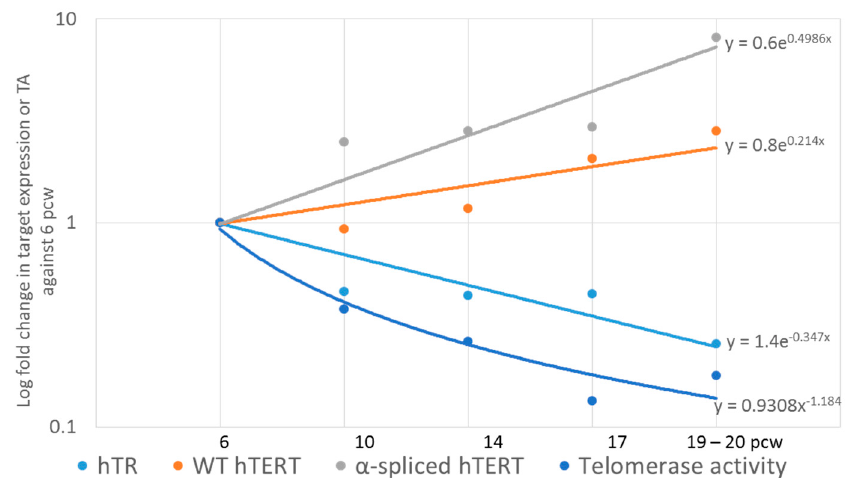
Figure 3. Summary of changes in expression of telomerase-related genes in fetal brain, young and old cortices. Data correspond to those from Figure 1. Telomerase activity and 2 −ΔΔ Ct of all data were acquired by normalizing to 6 pcw instead of SH-SY5Y (in the case of 2 −ΔΔ Ct data), allowing fold change comparison of any time point with 6 pcw. Rate of change in each target over development can be determined from the slope of the graphs.